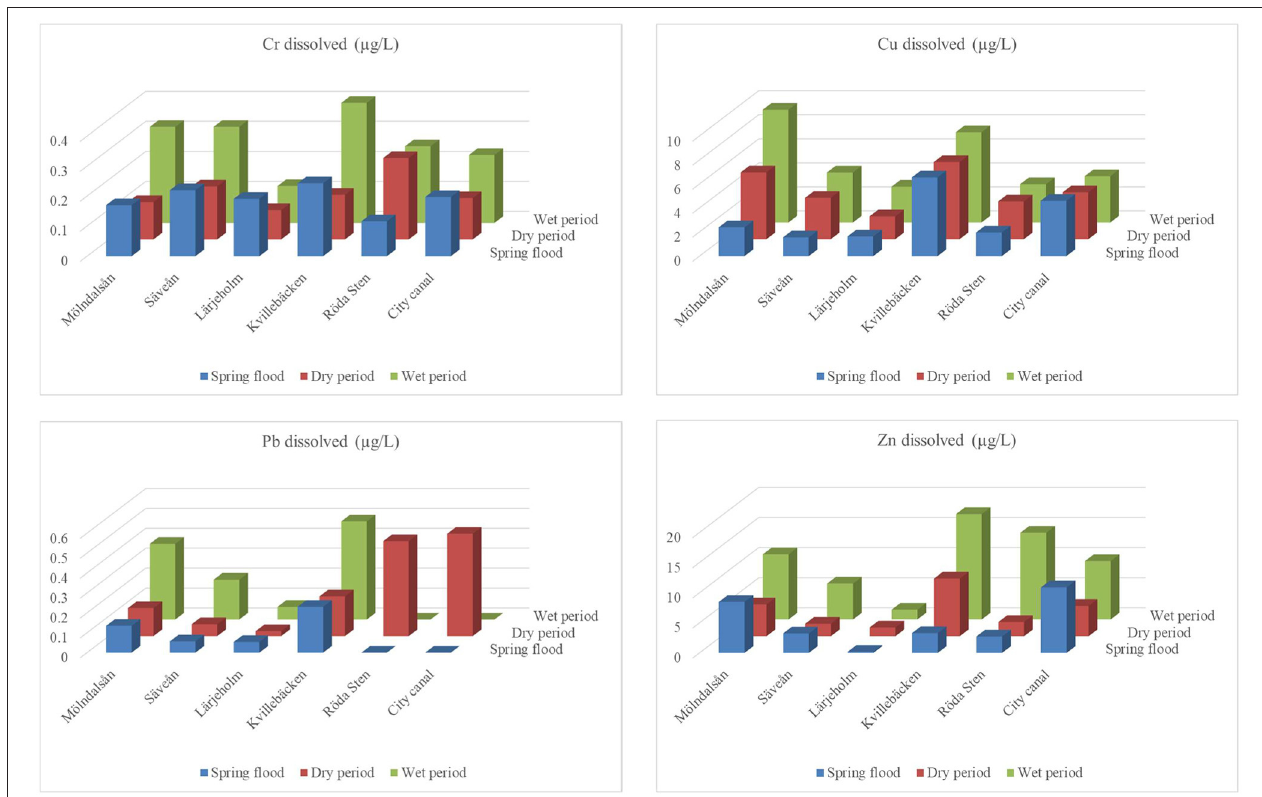
FIGURE 6 | Dissolved concentrations of Cu, Zn, Cr, and Pb at sampling sites during the Spring flood, Dry period, and Wet period sampling campaigns.